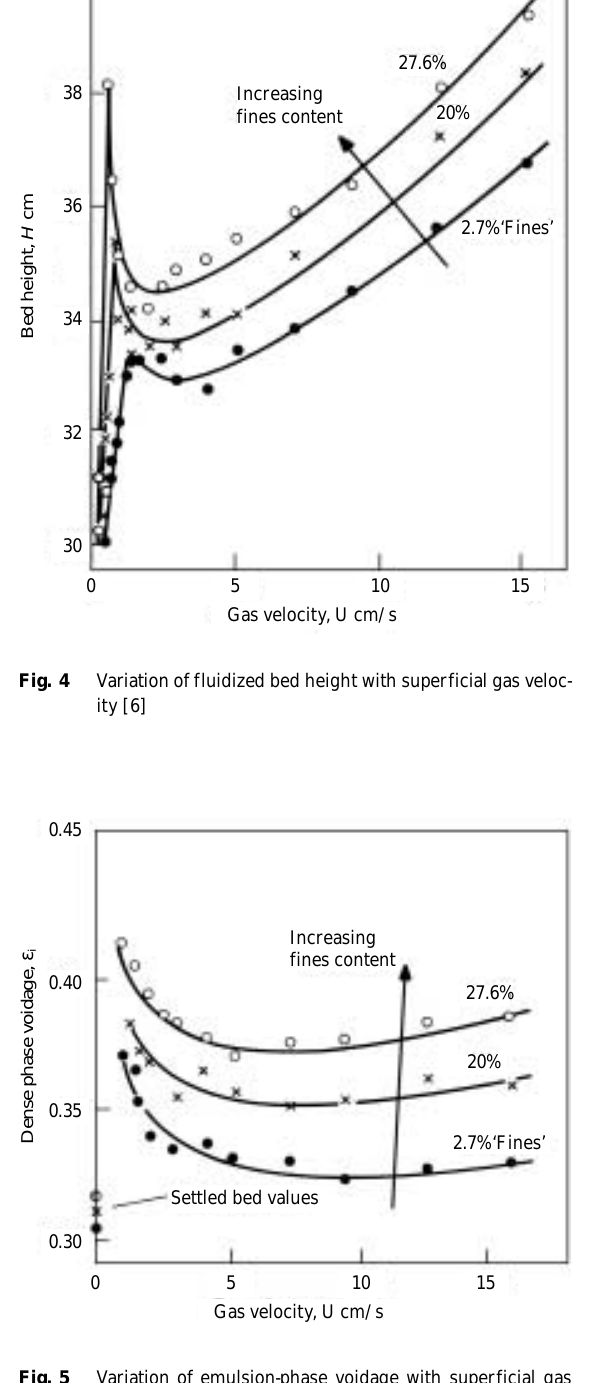
Fig. 5 Variation of emulsion-phase voidage with superficial gas velocity